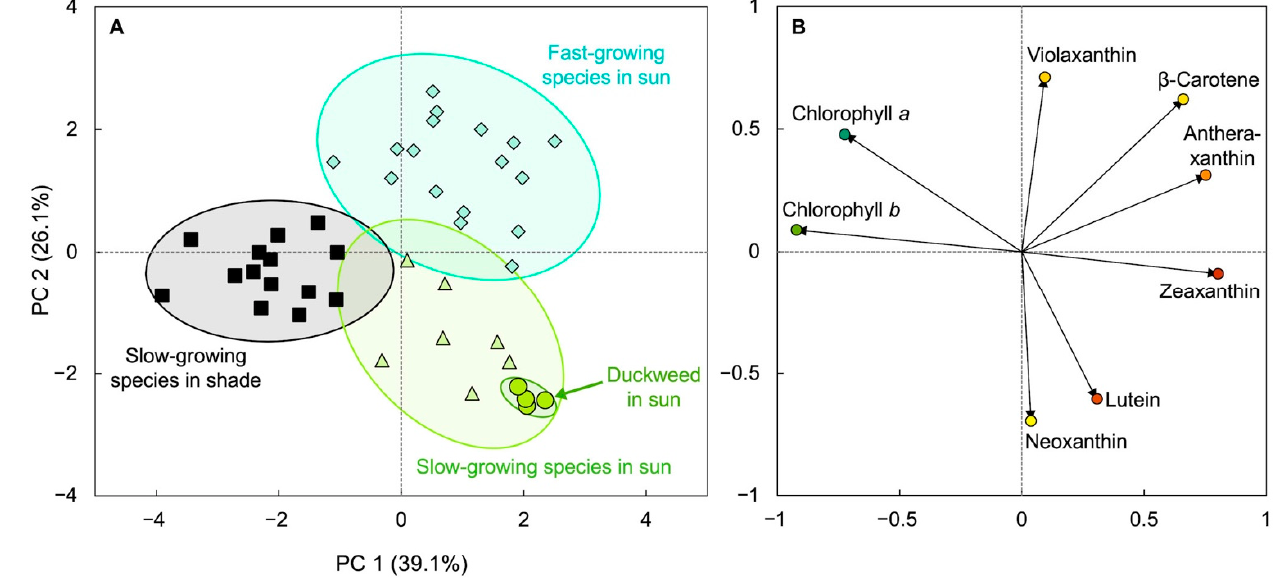
Figure 3. Principal component analysis showing ( A ) clusters of groups based on similarity (score plot) and ( B ) how each characteristic used influences a principal component, PC (loading plot). Characteristics used were the various leaf pigments of slow-growing terrestrial species either in shaded environments (black squares) or full sunlight (olive-green triangles), fast-growing (annual and biennial) species (turquoise diamonds) in full sunlight, and duckweed ( Lemna minor ) that was growing in full sunlight (olive-green circles) near Boulder, CO, USA (for details, see [24,25]). Data from [24,25].